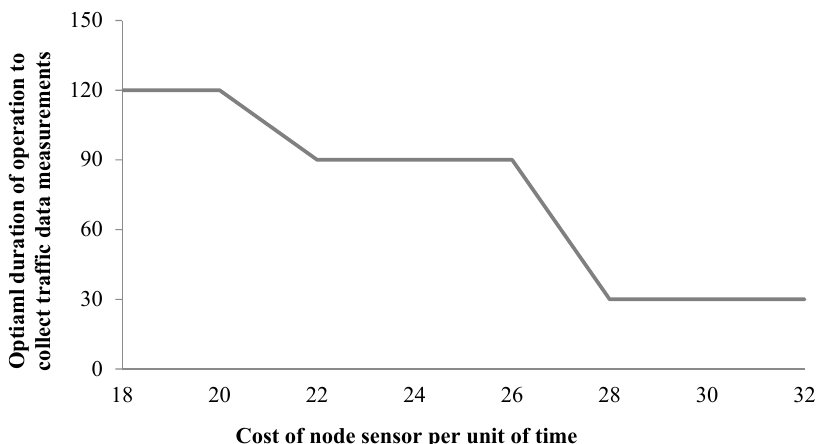
Figure 4. Optimal duration of operation for which traffic data measurements are collected with different node sensor cost per unit of time.